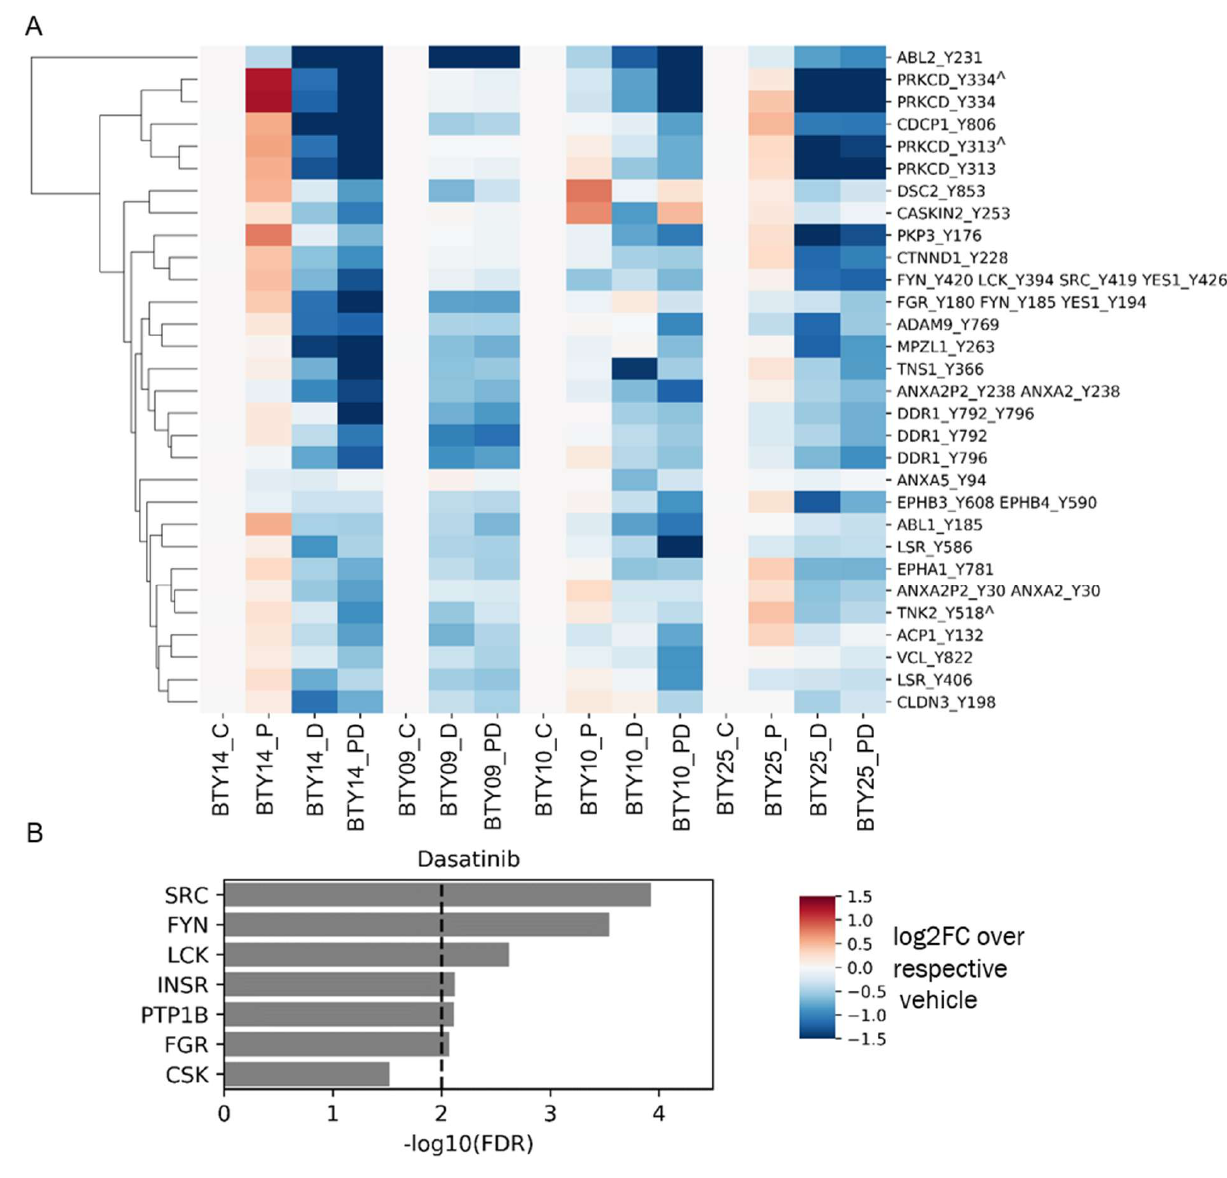
Figure 4. Phosphotyrosine response to therapeutics. ( A ) Heatmap of pTyr sites that were significantly downregulated after treatment with dasatinib compared to vehicle control ( n = 18 for vehicle group, n = 17 for dasatinib group) in all PDX lines. p values were corrected with the Benjamini–Hochberg procedure, to correct for multiple comparisons. Phosphorylation levels are presented as the log 2 of average fold change relative to the average of respective vehicle control groups ( n = 3–5/group, total 64 PDXs). Miscleaved peptides are represented by ˆ. ( B ) KEA of proteins that were signifi- cantly downregulated after dasatinib treatment in Figure 4A. A kinase-substrate library without the phosphosites was used for the KEA